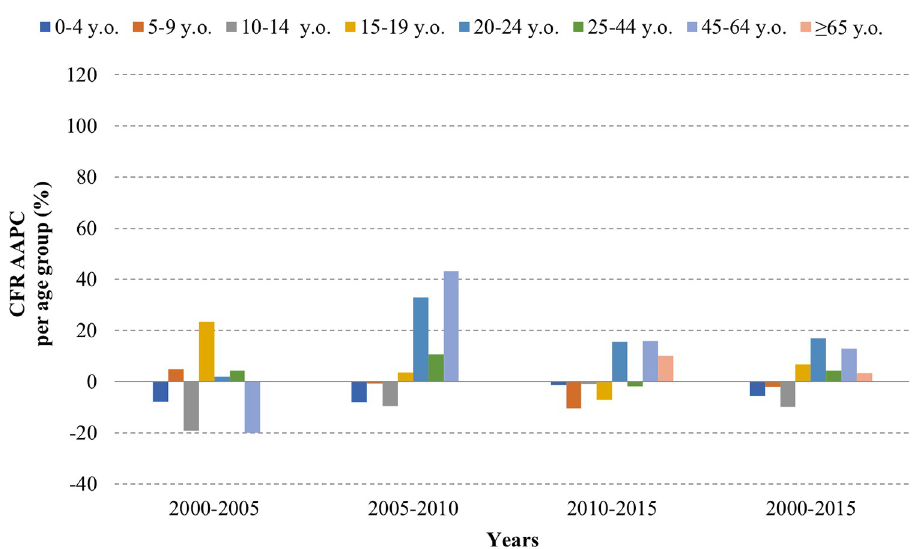
Fig 5. Average annual percent change in dengue case fatality rate per age group.